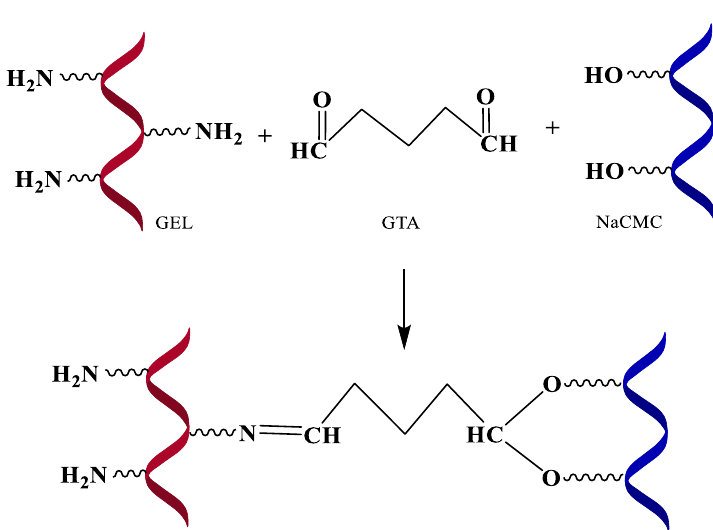
Fig. 1 The GEL/NaCMC hydrogel synthesis of